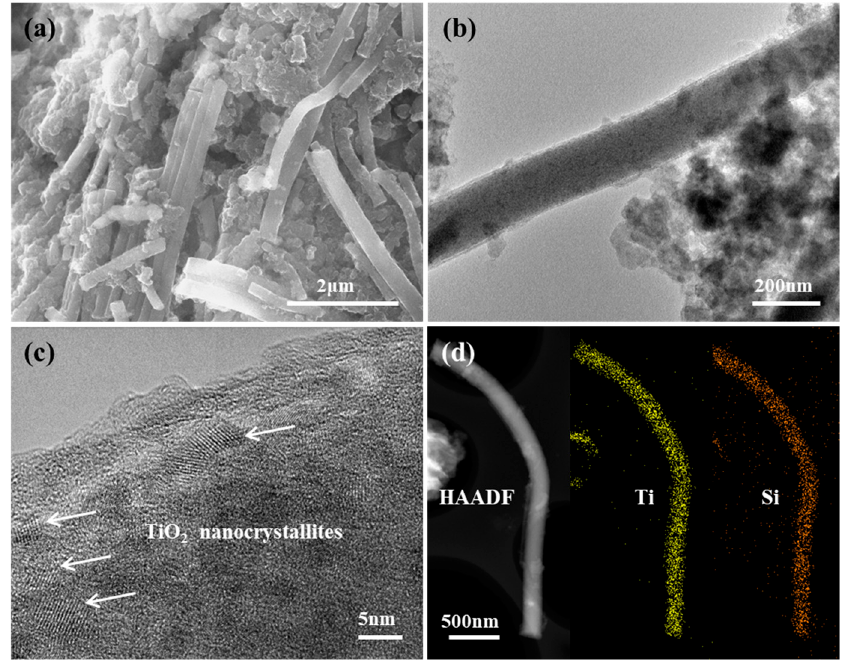
Figure 6. ( a ) SEM, ( b ) TEM, ( c ) HRTEM images of the TSC nanofiber electrode after 300 cycles at 100 mA/g. ( d ) HAADF-SEM image with corresponding EDS maps of Ti and Si elements in a single TSC nanofiber after